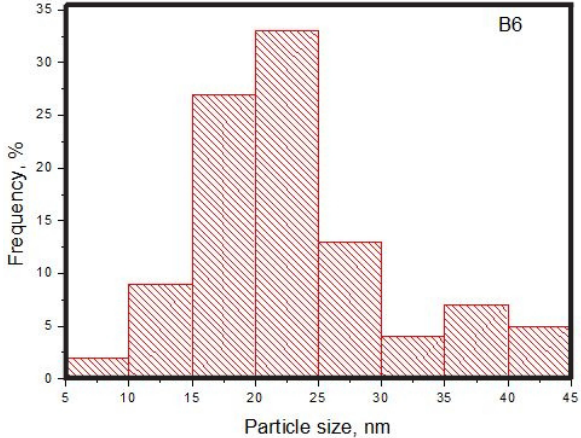
Figure 6 . Particles size distribution for ZC13/8 (based on the TEM micrograph, Figure 5,